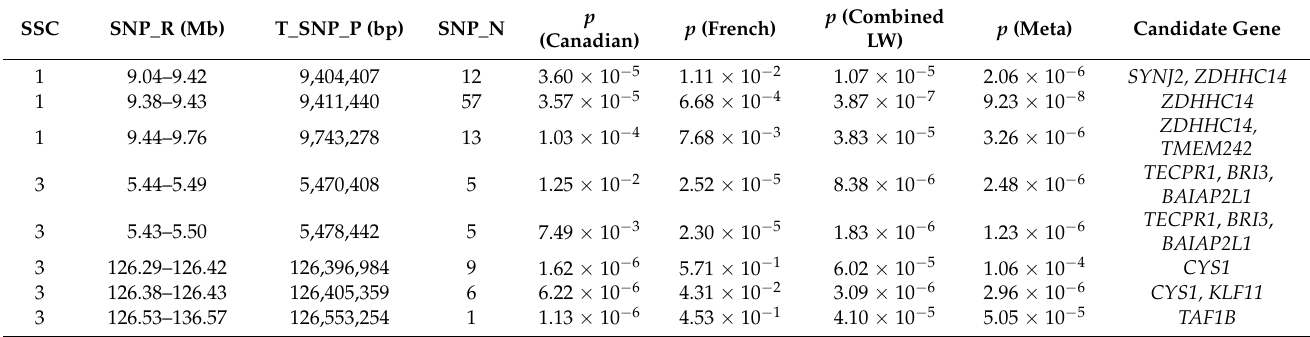
Table 4. The genome significant and suggestive SNPs with the number of stillborn (NSB) trait using imputed WGS data in